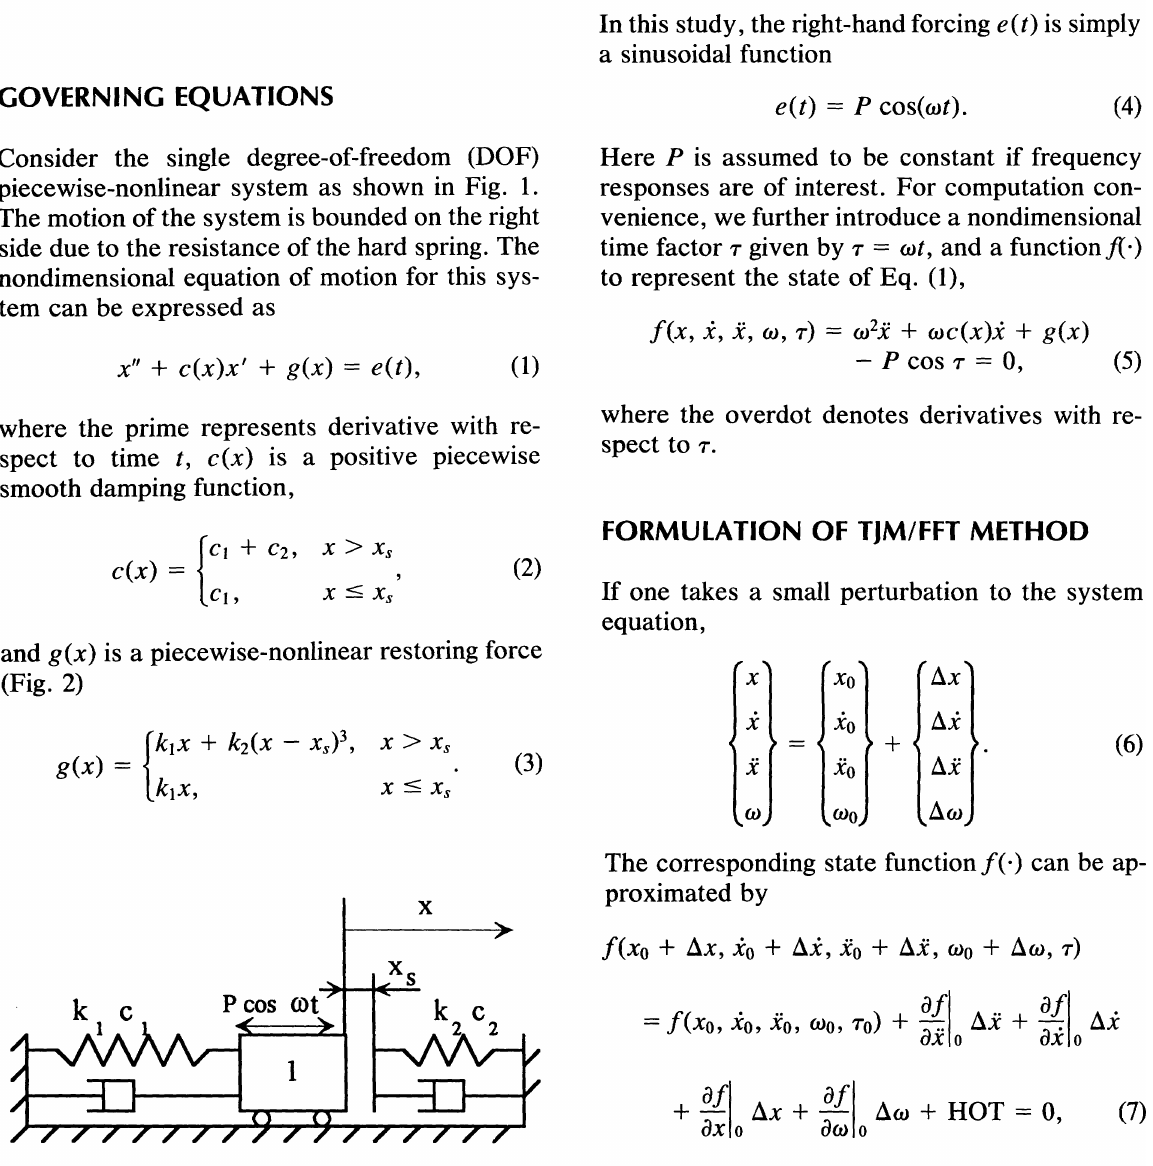
FIGURE 1 Piecewise-nonlinear system.